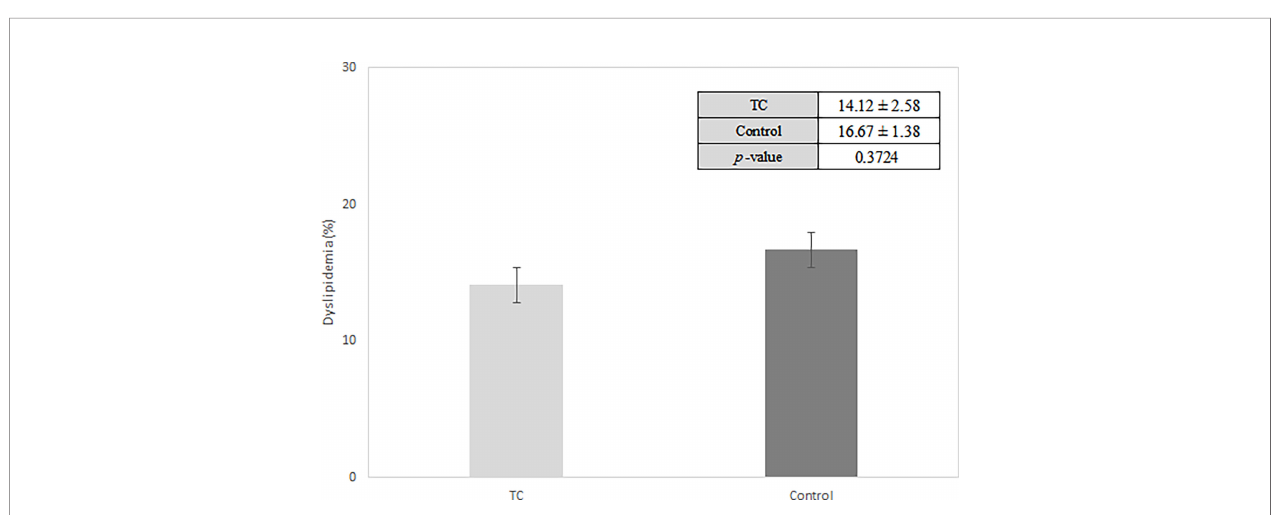
FIGURE 3 | Bar plot showing dyslipidemia risk in patients with thyroid cancer. TC, Thyroid cancer; Values are presented as mean ± standard